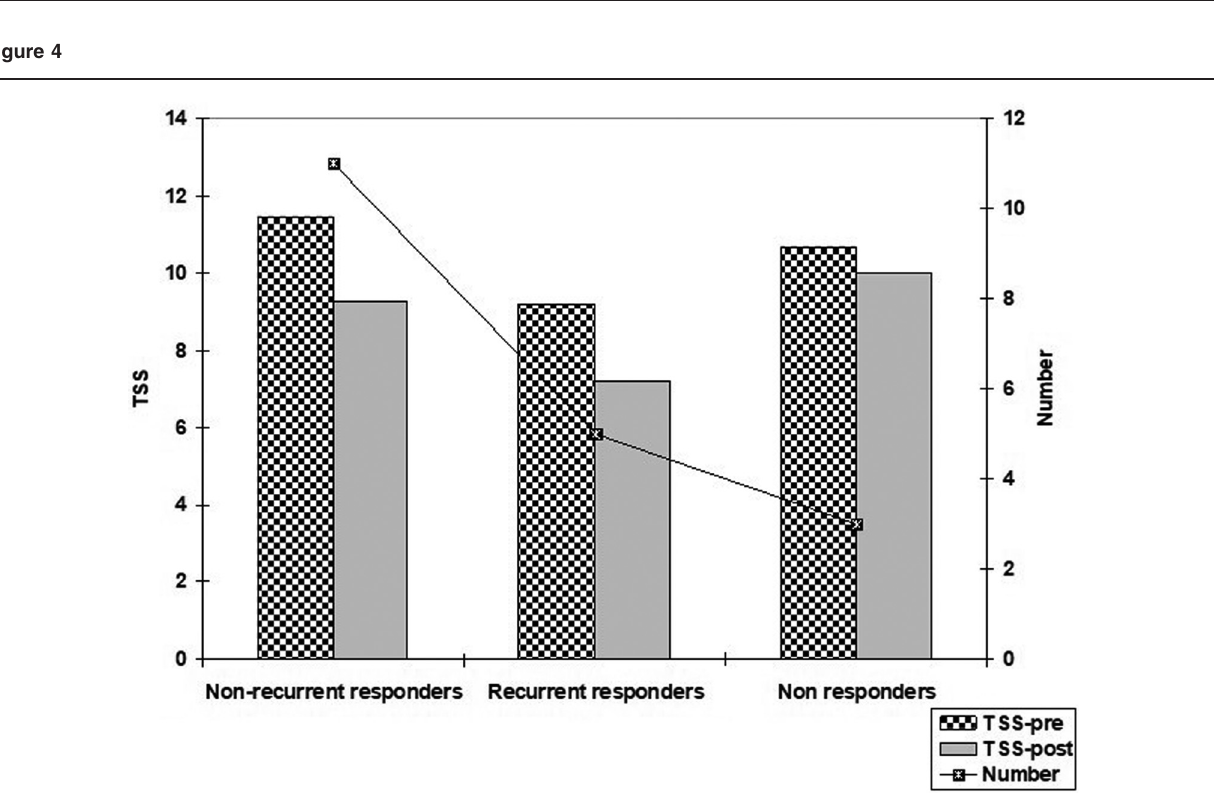
responders, at the end of follow-up, mean endoscopic scores were significantly lower compared with pre-ttt scores( P = 0.015)andscoresofnonrespondersatthetime of shift to FESS ( P = 0.035). CT scores of study group